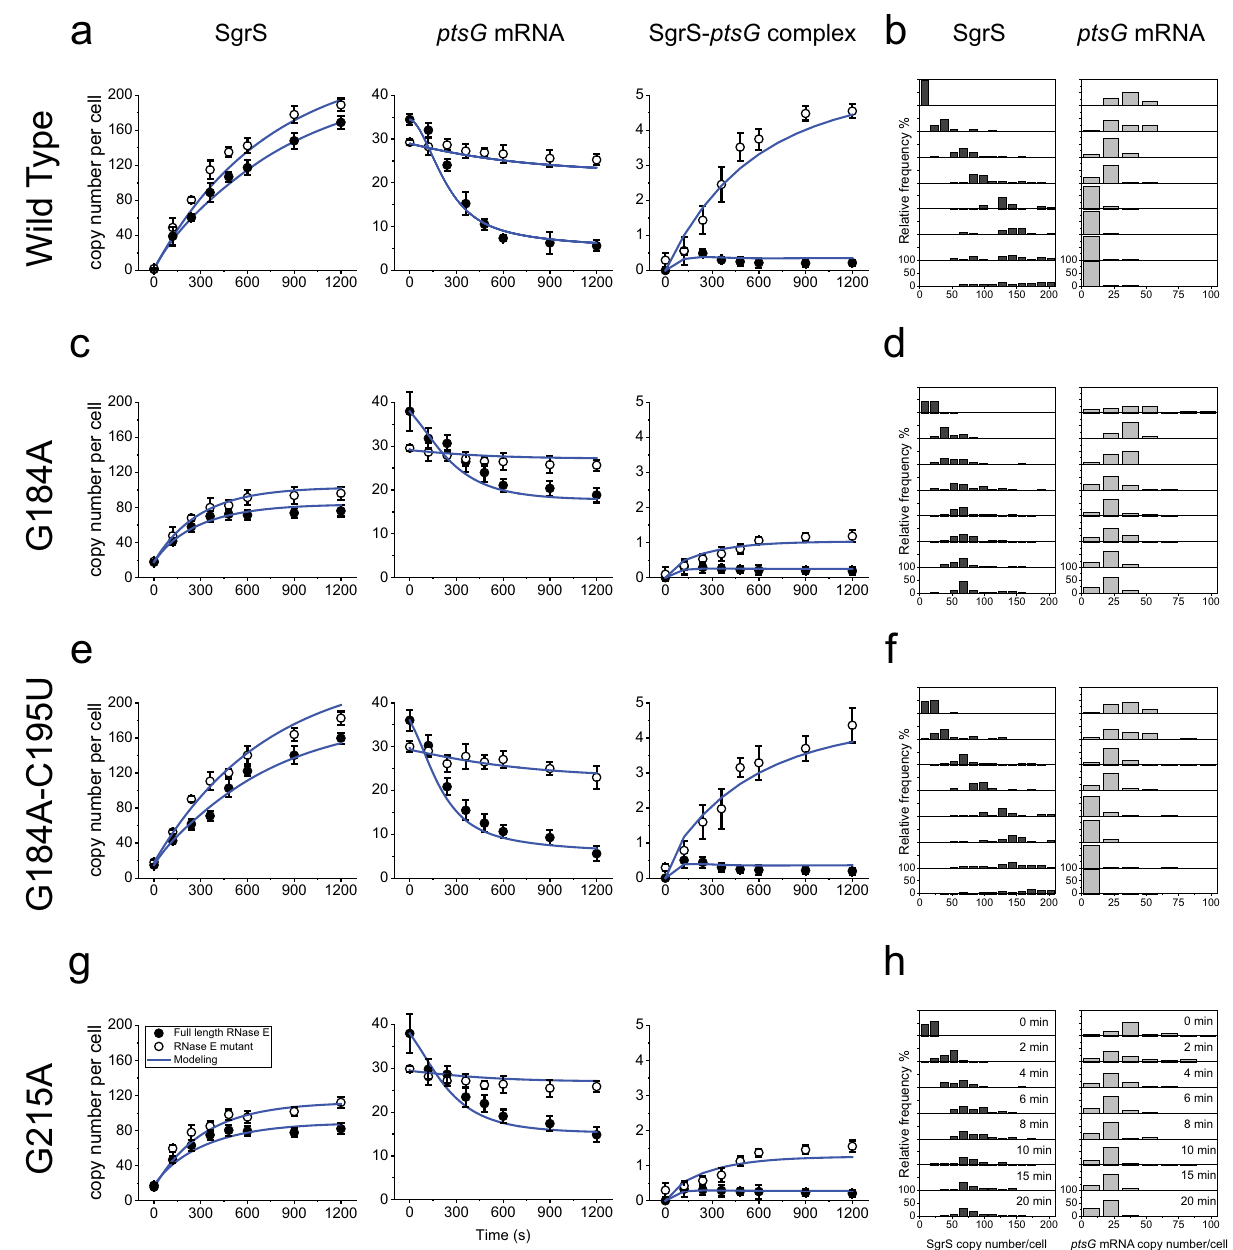
Fig. 5 Time-dependent changes in the copy numbers of SgrS and ptsG mRNA and estimation of kinetic parameters. Time course changes and corresponding modeling curves for the SgrS, ptsG mRNA, and SgrS- ptsG complex in a wild type, c G184A mutant strain, e G184A – C195U mutant strain, g G215A mutant strain. Average copy numbers per cell are plotted against time. Rate constants obtained for these mutants are shown in Fig. 6 and in Supplementary Table 3. Weighted R 2 ’ s for modeling are also reported in Supplementary Table 4. Data are presented as mean values ± SEM for n = 98, 90, 169, 144, 149, 127, 94, and 82 cells examined over two independent experiments after 0, 2, 4, 6, 8, 10, 15, and 20 min induction respectively for a ; for n = 84, 84, 94, 99, 94, 90, 87, and 88 cells examined over two independent experiments after 0, 2, 4, 6, 8, 10, 15, and 20 min induction, respectively, for c ; for n = 117, 101, 115, 111, 102, 110, 104, and 104 cells examined over two independent experiments after 0, 2, 4, 6, 8, 10, 15, and 20 min induction, respectively, for e and for n = 82, 88, 94, 104, 94, 90, 89, and 88 cells examined over two independent experiments after 0, 2, 4, 6, 8, 10, 15, and 20 min induction, respectively, for g . Histograms showing the change in distribution of SgrS and ptsG mRNA copy numbers for b wild type for n = 98, 90, 169, 144, 149, 127, 94, and 82 cells examined over two independent experiments after 0, 2, 4, 6, 8, 10, 15, and 20 min induction, respectively, d G184A mutant strain for n = 84, 84, 94, 99, 94, 90, 87, and 88 cells examined over two independent experiments after 0, 2, 4, 6, 8, 10, 15, and 20 min induction, respectively, f G184A – C195U mutant strain for n = 117, 101, 115, 111, 102, 110, 104, and 104 cells examined over two independent experiments after 0, 2, 4, 6, 8, 10, 15, and 20 min induction, respectively, h G215A mutant strain for n = 82, 88, 94, 104, 94, 90, 89, and 88 cells examined over two independent experiments after 0, 2, 4, 6, 8, 10, 15, and 20 min induction, respectively. Source data are provided as a Source data fi